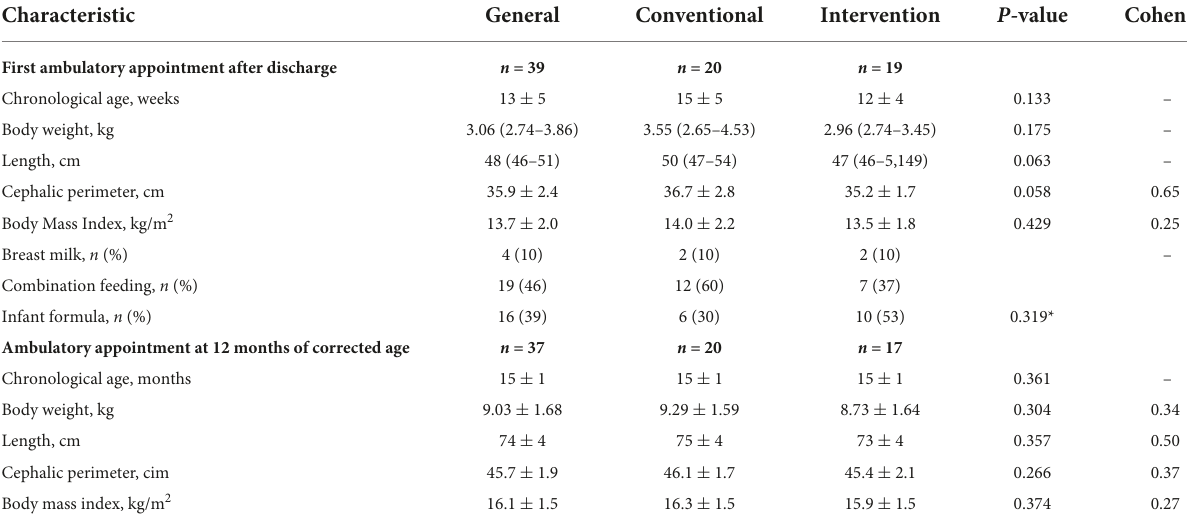
TABLE 2 Physical exam in the first ambulatory follow-up visit after NICU discharge and 12 months corrected age of preterm children subjected to early intervention program compared to conventional care.